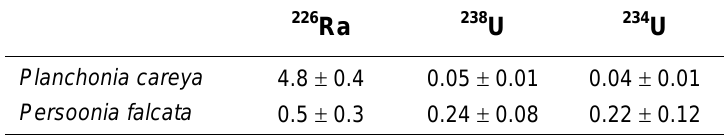
Mean Radionuclide Activity Concentrations (Bq kg –1 Fresh